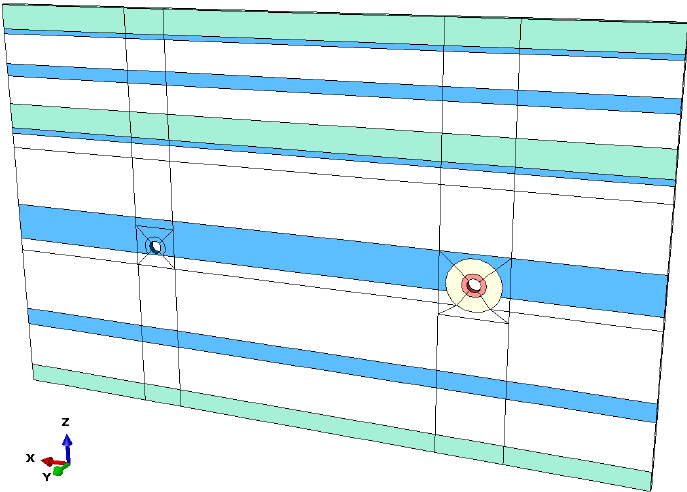
Figure 3. Numerical model of coal roadway and rock layers.